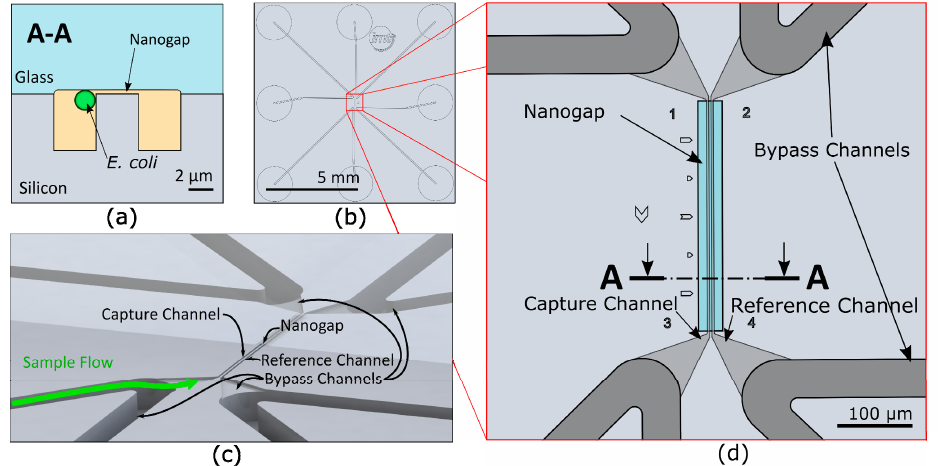
Figure 1. ( a ) Cross-section of the capturing area with a bacterium moving towards the nanogap, driven by a pressure difference between the channels. ( b ) Schematic top view of the 10 × 10 mm silicon-glass chip with eight microfluidic inlets and outlets at the bottom of the chip. ( c ) Schematic three-dimensional view of the capture features of the chip. ( d ) Detailed top view of the capture area in the red box with capture and reference channels, bypass channels, and nanogap area.